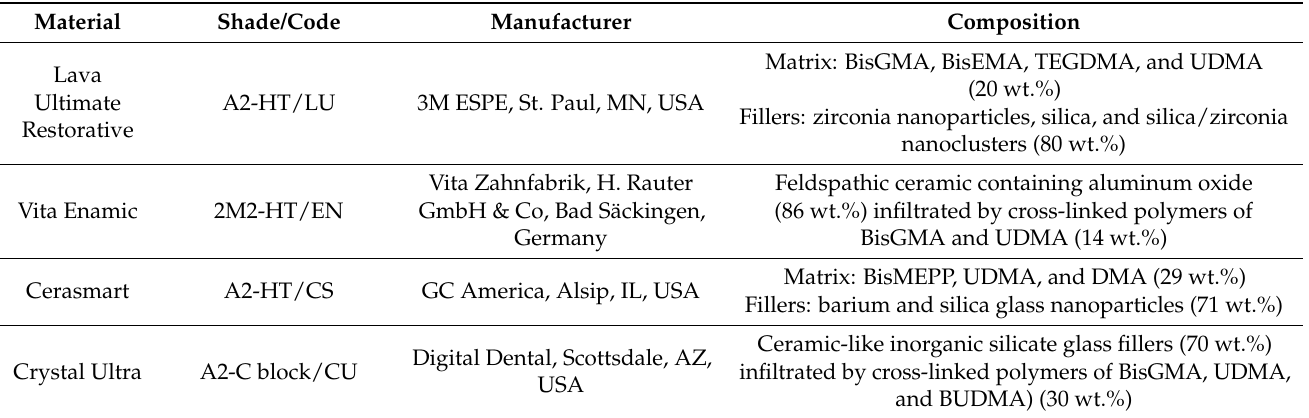
Table 1. Resin-modified CAD/CAM ceramic